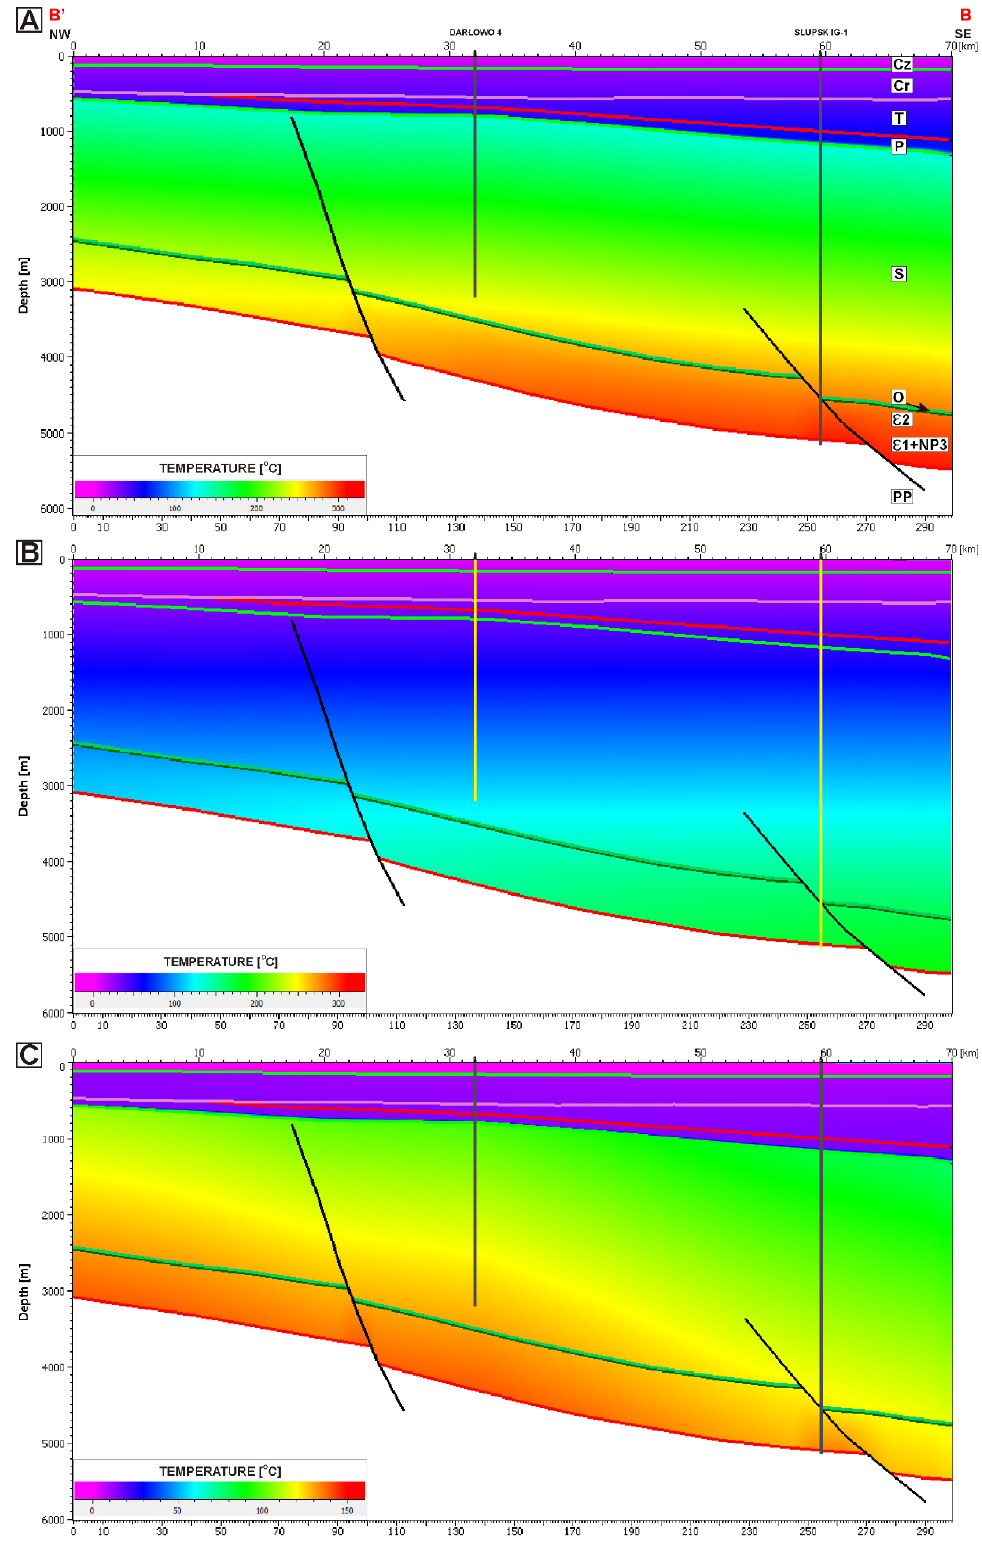
Figure 10. Models of temperature changes in geologic history of the study area: ( A ) Maximum temperatures attained by rocks of sedimentary cover in the geologic history. ( B ) Distribution of recent temperatures within the sedimentary cover. ( C ) Distribution of differences between the maximum and the recent temperatures within the sedimentary cover.